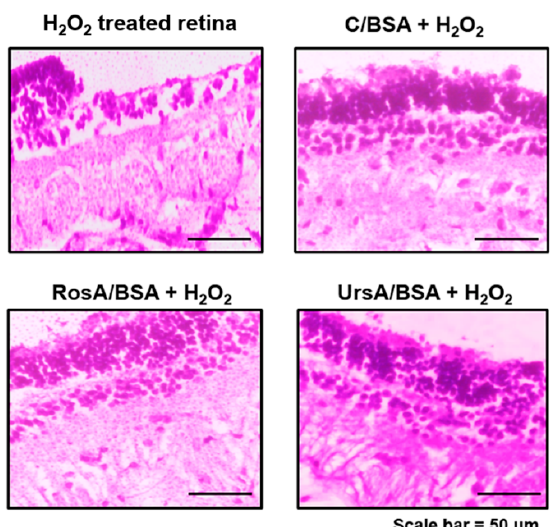
Figure 11. Histological examination of rabbit retina tissues after drug treatment (C/BSA, RosA/BSA, or UrsA/BSA formulation of 50 µM) and then H 2 O 2 solution treatment. After the retinas were incubated with drug formulations for 18 h, the tissues were treated with 30 µg/mL H 2 O 2 additionally. Tissue sections were subjected to H&E staining and examined with a brightfield microscope (20× objective).